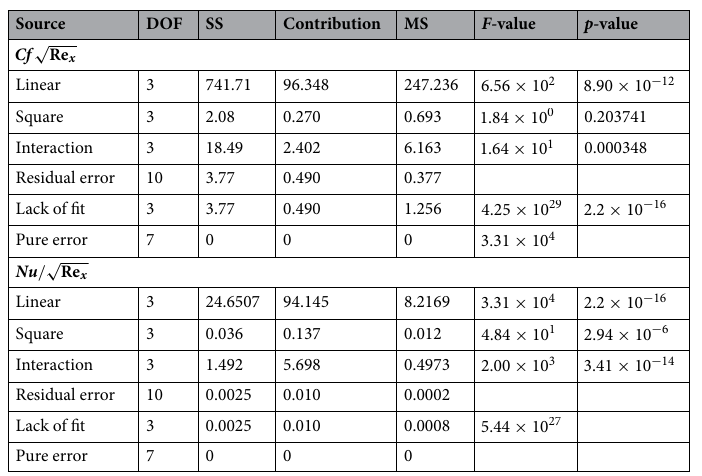
Table 6. ANOVA analysis for Cf √ Re x and Nu / √ Re x .